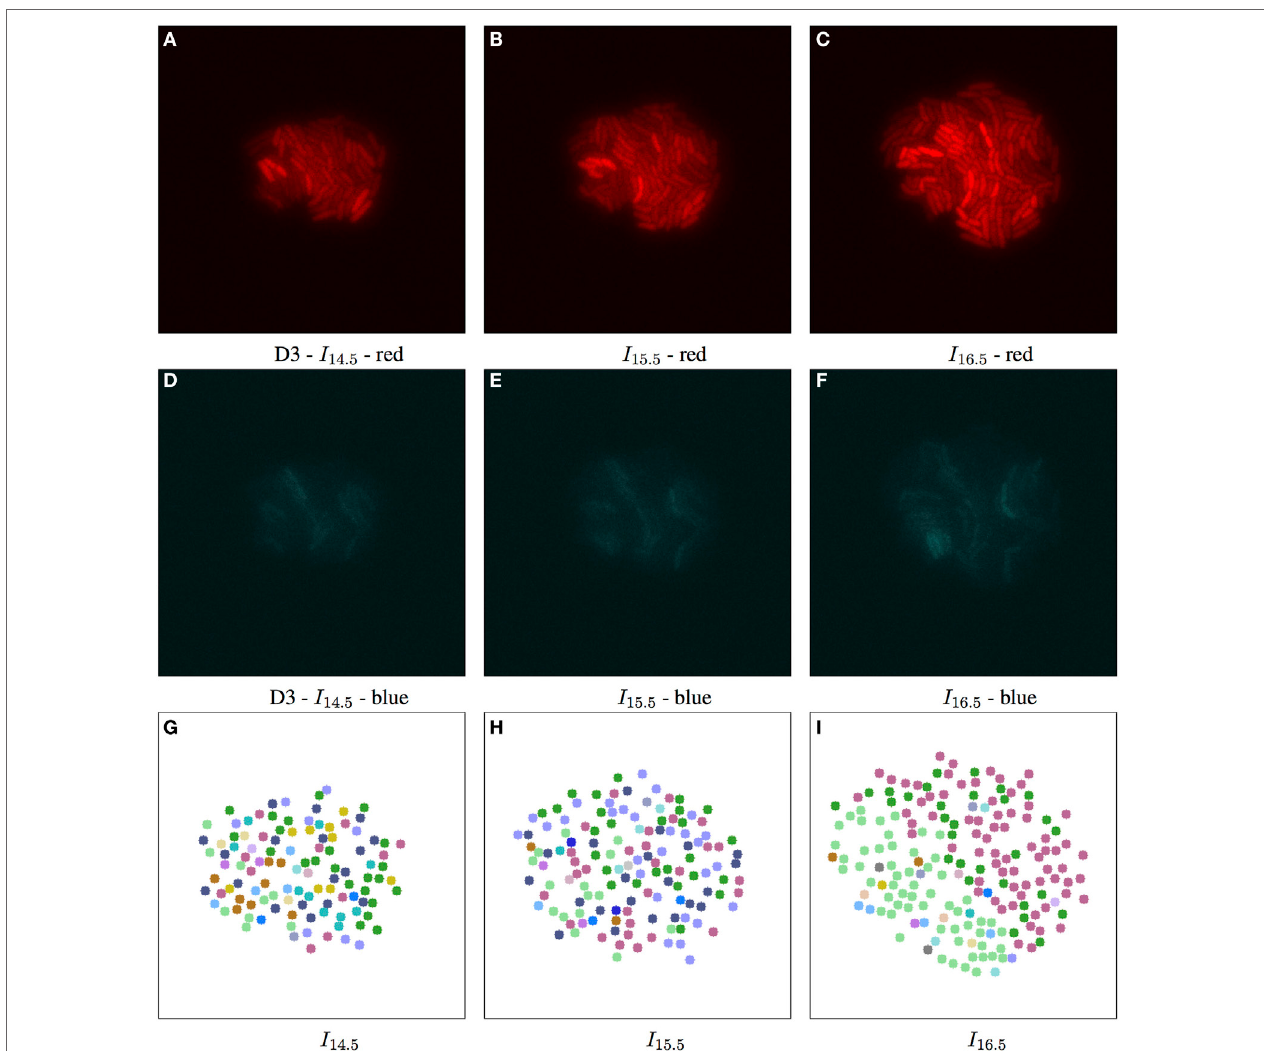
Figure 6 | Biomovie D3 with RGB channels of image points 14.5, 15.5, and 16.5 h, and their corresponding patch structure, respectively. Enhanced exposures for red: 60% and blue: 90%. The S. meliloti bacterial cells are bio-engineered to fluoresce in a particular way, where each channel encodes a certain trait, or behavior. The red (a–c) and blue channels (D–F) show certain behavior in response to changes of conditions; here the bacterial cells are of wild type, and exposed to high concentrations of phosphate, influencing bacterial communication. The green channel is omitted due to its homogenous fluorescence. The patch structure is found using the following thresholds: geometric distance 100 px, and specific channel differences of red: 20, green: 50, and blue: 50. Main images show 7-px dots at computed particle locations. (g–i) The split/merge computation has been run, and particles are colored by their patch